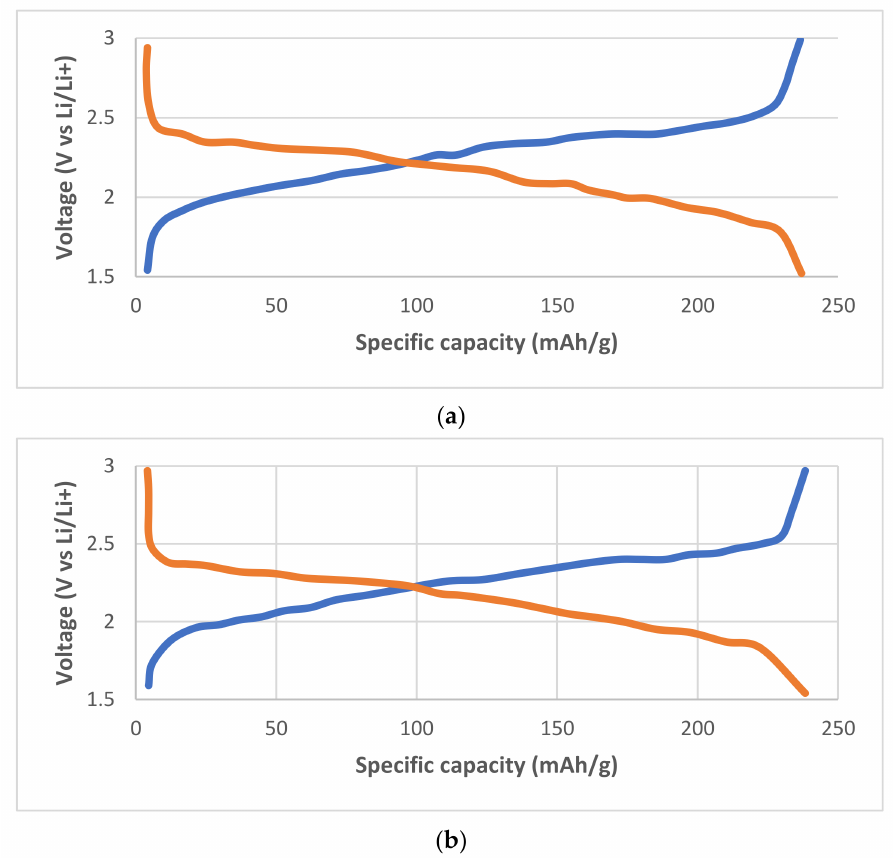
Figure 2. Comparison of Li 6 PS 5 Cl ASSB by ( a ) solid-state procedure ( b ) solution-synthesized proce- dure of TiS 2 /Li 6 PS 5 Cl/Li 11 Sn 6 cells at current density, 100 µ A · cm − 2 (equivalent to 0.11 charge rate). Reprinted with permission from ACS Energy Lett . 2019 , 4 , 1, 265–270